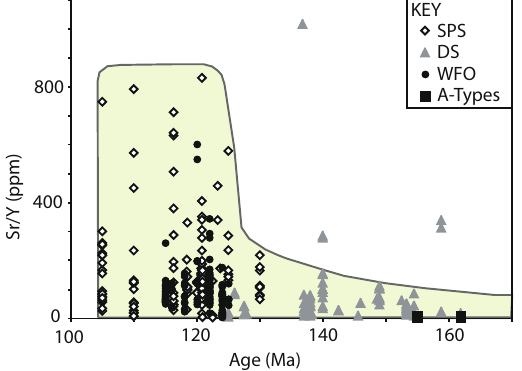
Figure 2. Sr/Y (ppm) over time displays the shift to a garnet rich, plagioclase free source at < c. 130 Ma (Geochemical data from Allibone et al. 21, 22 and references